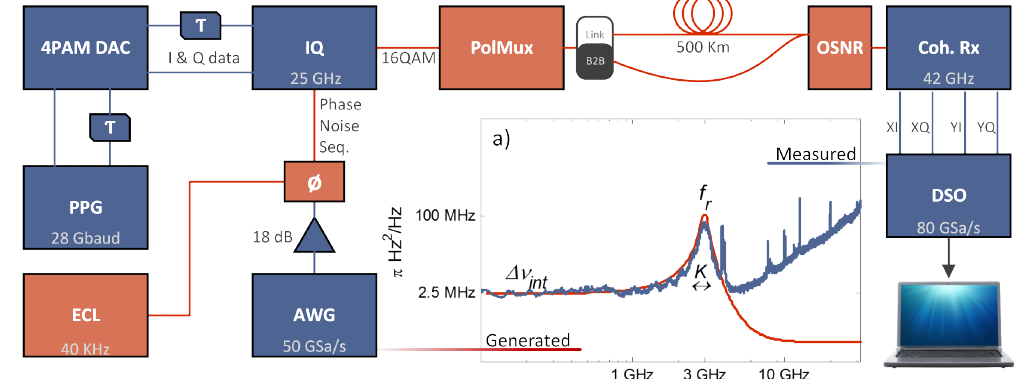
Figure 6. Experimental Setup: inset ( a ) shows the power spectral densities for emulated and measured frequency noise.